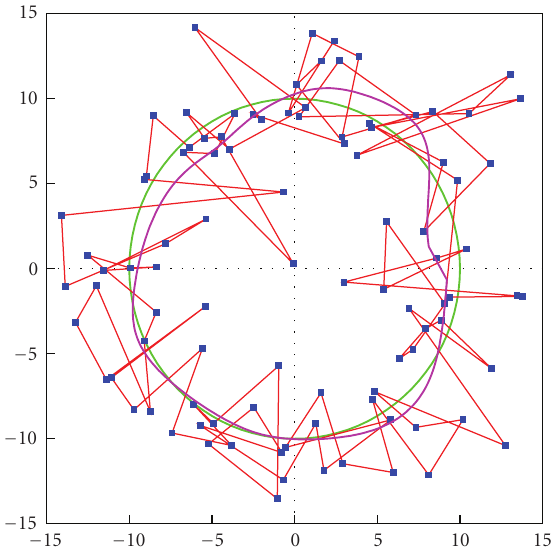
Figure 2: Recovery of the boundary of disk specified by 96 points with Gaussian noise of ν = 3, starting at (1,0) on the x -axis and moving counterclockwise around the circle with the boundary recovered using approximate interpolation, with σ A = 1 × 10 − 6 and σ − 4 . The recovered curve is shown as a thicker B = 1 × 10